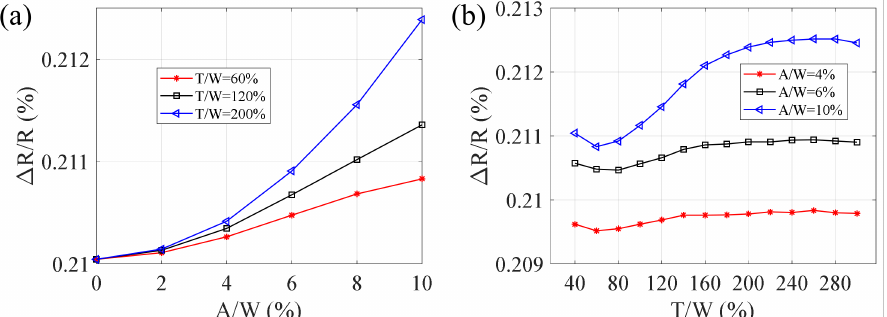
Figure 4. RRC and GF are affected by the geometrical parameters of ( a ) RP and ( b ) RA in the cosine profile. The loaded strain is 500 µ